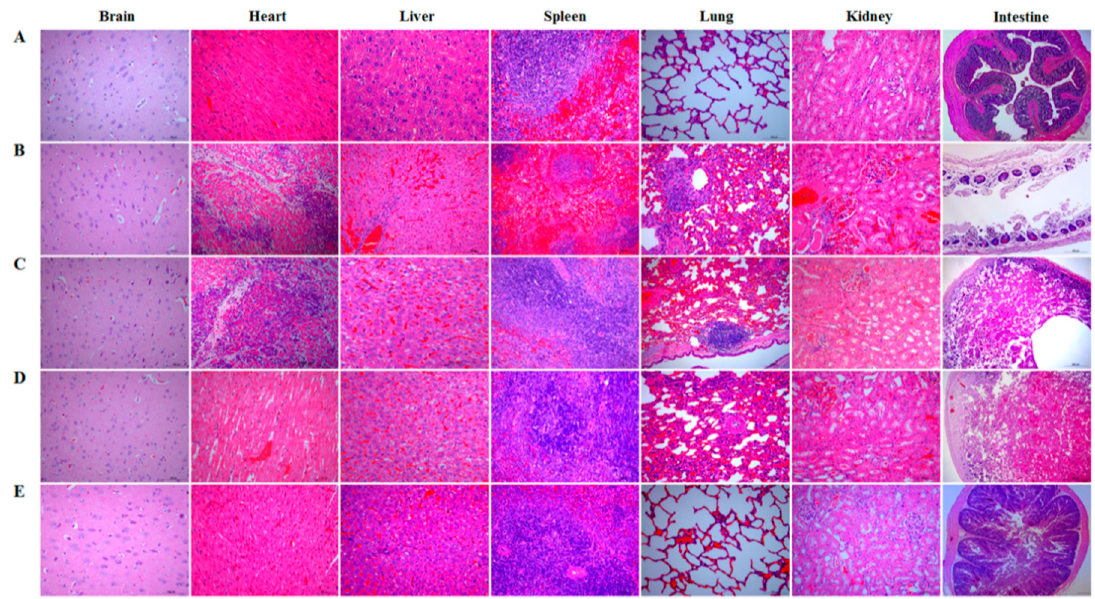
Figure 8. Histopathological changes in the brain, heart, liver, spleen, lung, kidney, and intestine tissues of the rabbits in each group were observed after intramuscular injection with 1 × LD 100 of crude exotoxin mixture produced by C. perfringens toxinotype A, C, and D combined with oral administration of C. perfringens toxinotype A, C, and D culture. Sections were stained with hematoxylin and eosin and photographed at 40× magnification. ( A ) normal group; ( B ) PBS group; ( C ) pPG-T7g10/ L. casei group; ( D ) commercial vaccine group; ( E ) bait particle vaccine group. Vaccines 2020 , 8 , x FOR PEER REVIEW